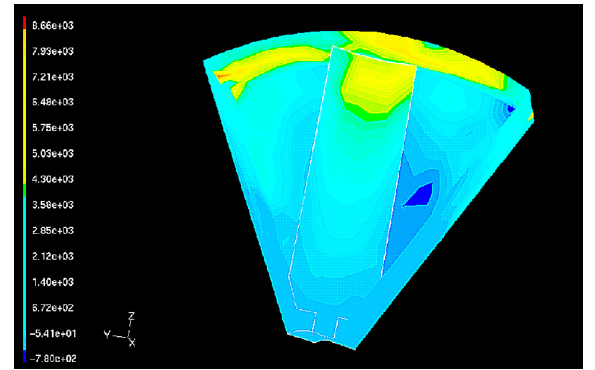
Figure 15: Dynamic pressure on the suction side without radiator (unit in Pascal).